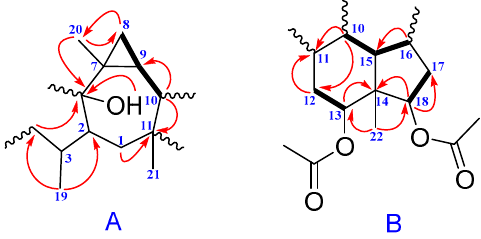
Figure 2. 1 H– 1 H COSY (bold) and selected HMBC (arrow) correlations of 1.